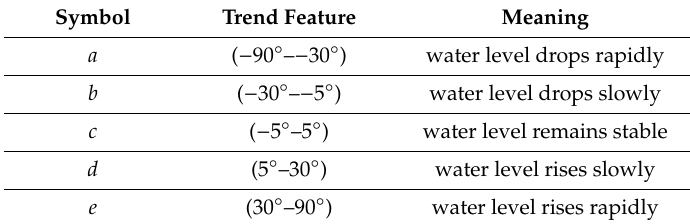
Table 6. The character sets and their meanings for the trend feature.